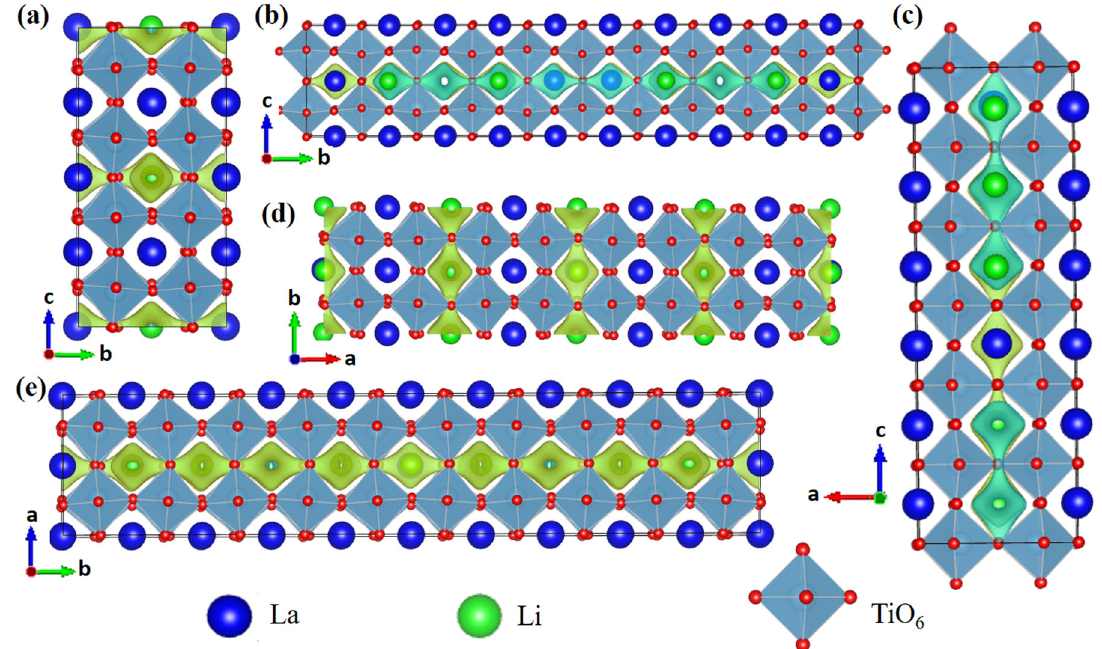
Fig. 8 Ordered ground states of Li 3 x La 2/3 − x TiO 3 . 3 x = a 0.125, b 0.2, c 0.25, d 0.3125, and e 0.35. Li-ion diffusion is anisotropic because of the blocking effect of La.